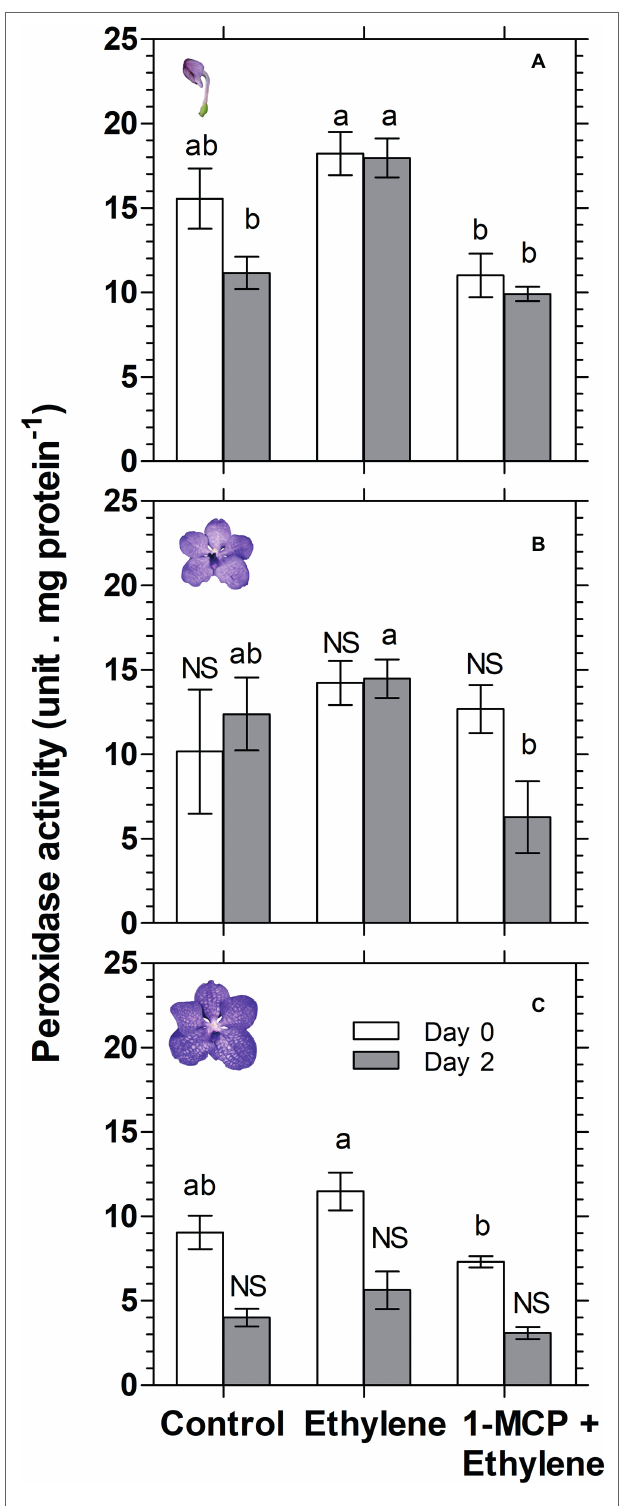
FIGURE 8 | Effect of ethylene and 1-MCP pre-treatments on changes in total peroxidase (POD) activity of Vanda ‘Sansai Blue’ cut flowers assayed at different developmental stages of colored bud (A) , half bloom (B) ,